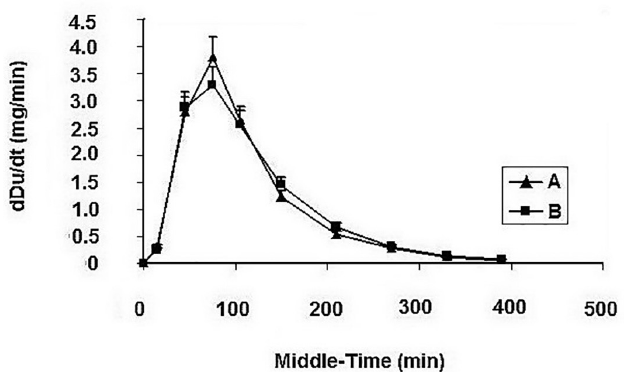
FIGURE 4 - Mean of urinary excretion rates ( dDu/dt ) followed by oral administration of cephalexin immediate-release tablets (A and B products, n=24).